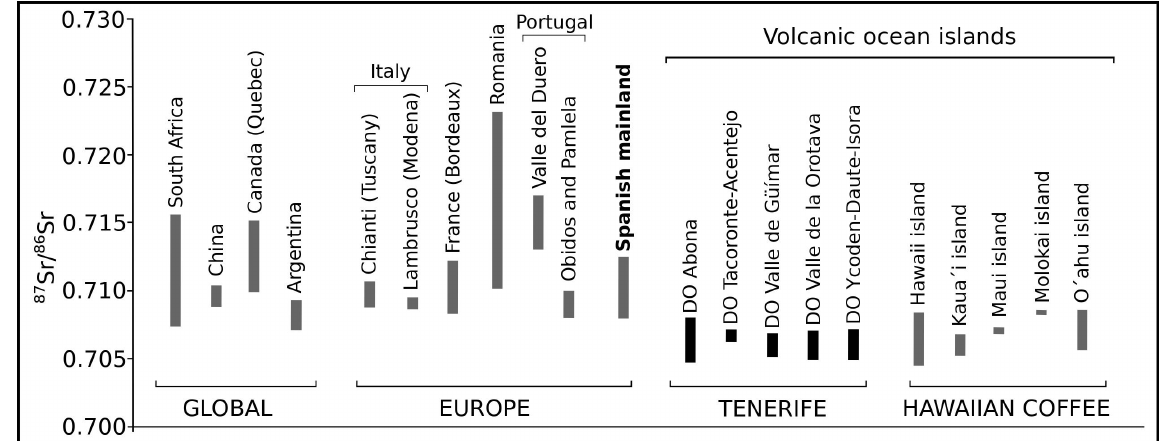
Figure 5. Sr isotopic signatures of Tenerife wine in a European and global context [11,13,44–48]. A comparison with another oceanic island setting (young, fresh rocks and soils) can be made by looking at the 87 Sr/ 86 Sr signature of Hawaiian coffee [43].